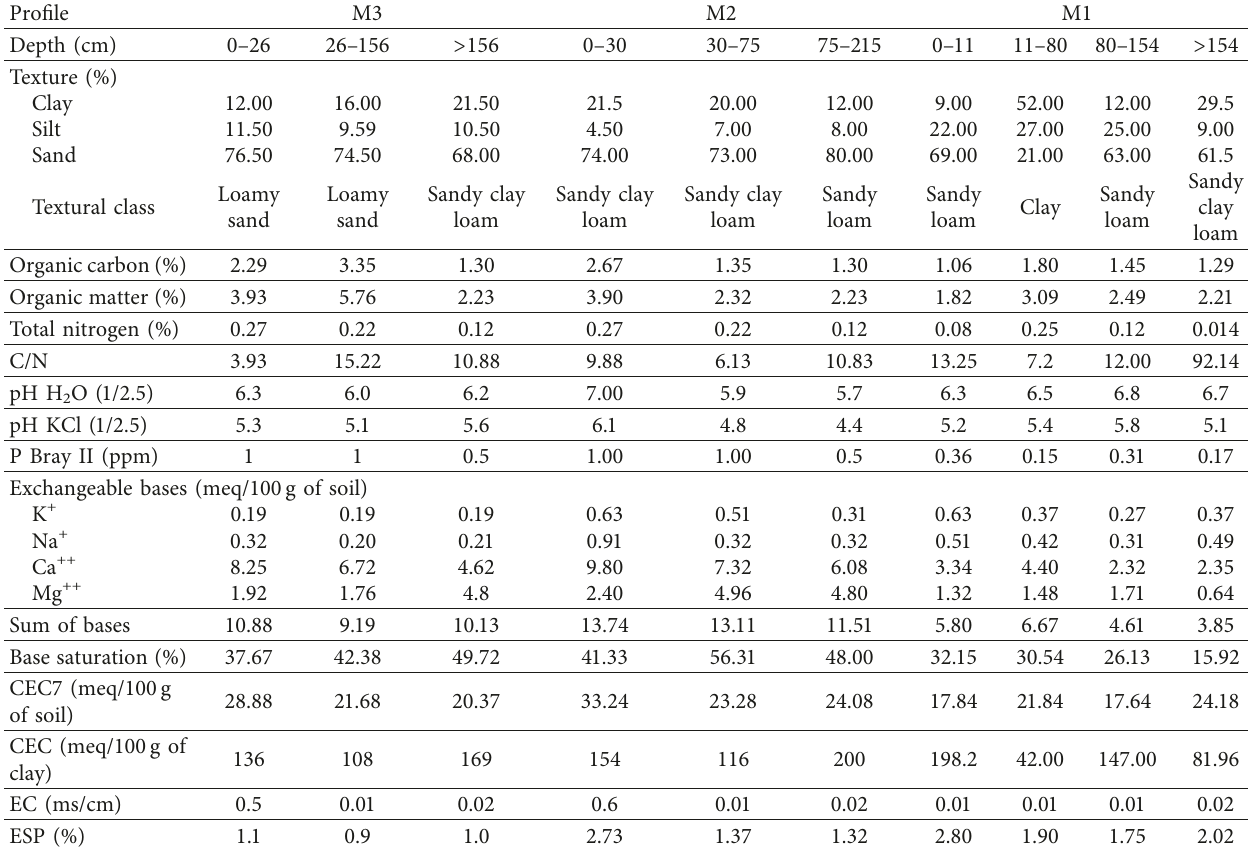
Table 3: Physicochemical characteristics of the studied soils.